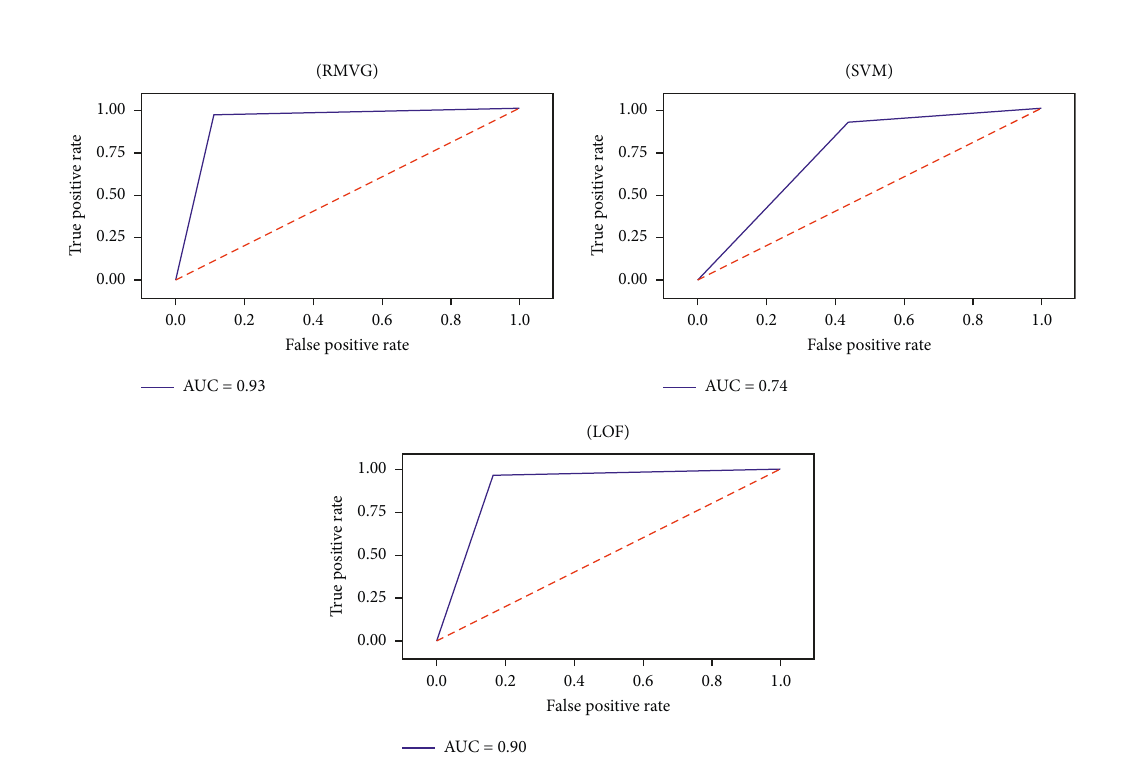
Figure 8: ROC and AUC